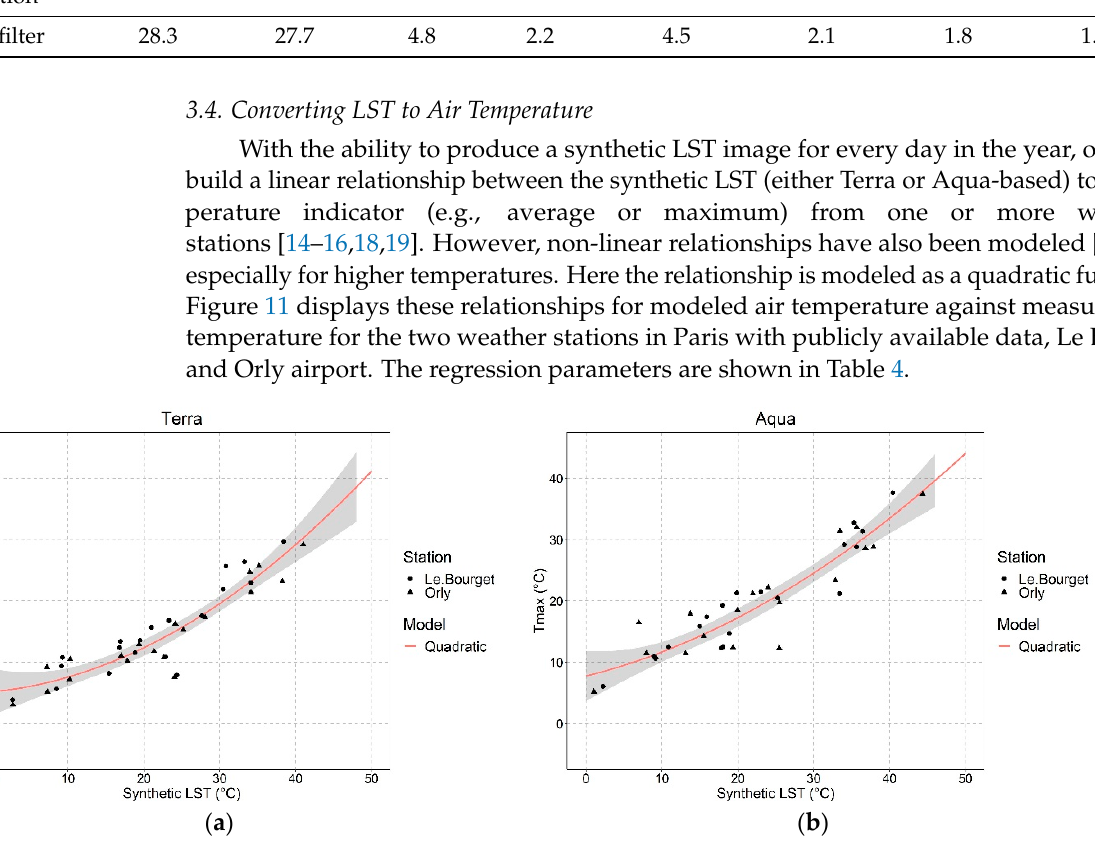
Figure 11. Quadratic regression models. T avg versus Terra synthetic LST ( a ) and T max versus Aqua synthetic LST ( b ). Table 4. Model parameters—T avg and T max as second order polynomial function of synthetic LST.